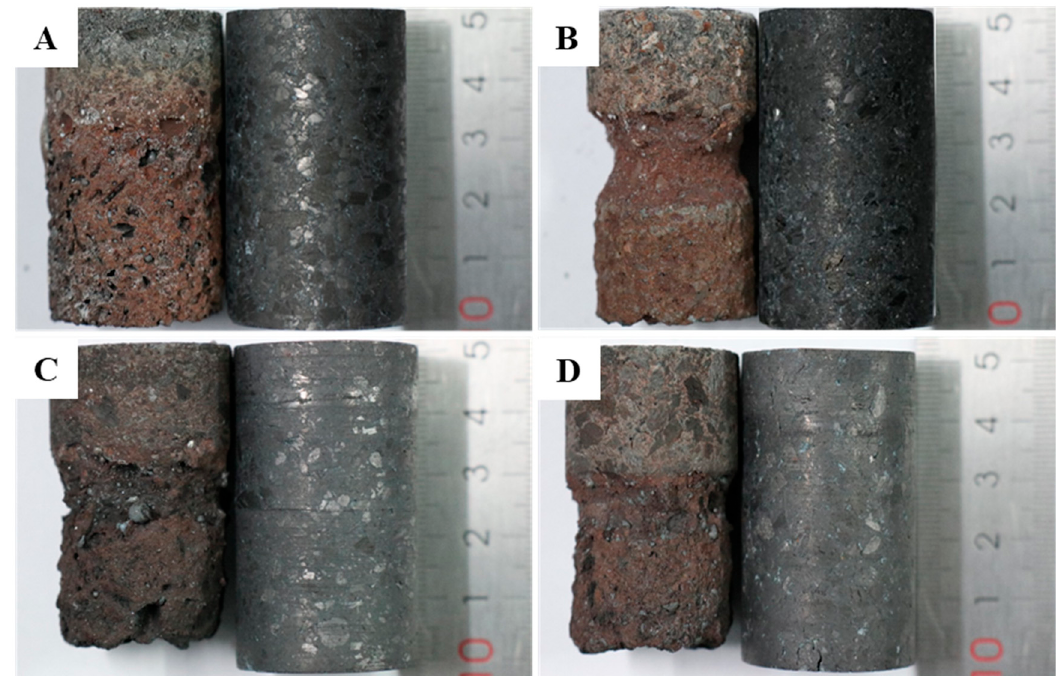
Figure 4. Macroscopic morphology of carbon bricks before and after corrosion ( A – D are the types of carbon bricks).